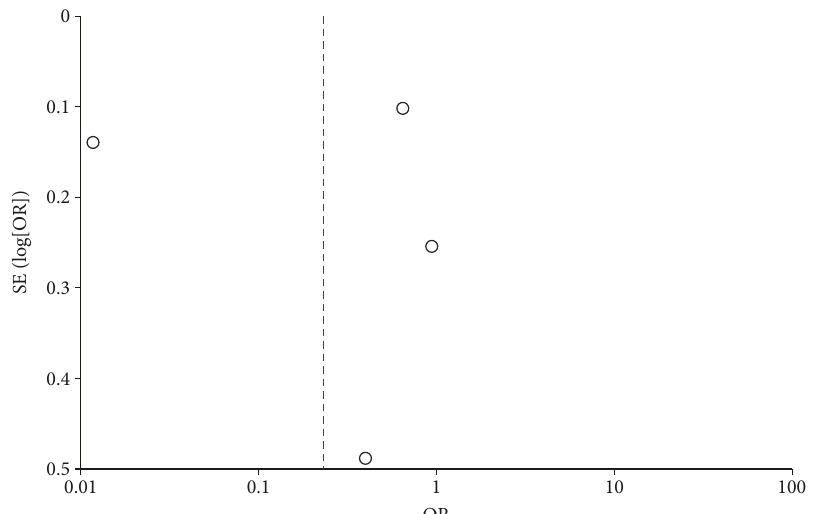
Figure 7: Incident hospitalization with COVID-19 with and without AR of stay funnel